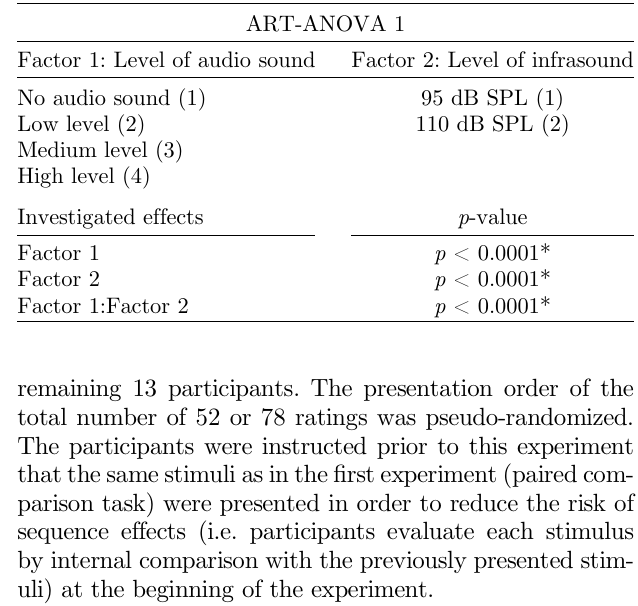
Table 2. The factors values, investigated effects and p -values of ART-ANOVA 1 are listed. Signi fi cant effects and signi fi cant interactions ( p < 0.05) are indicated by an asterisk. The factor value “ low level (2) ” of the factor ‘ level of audio sound ’ includes the unpleasantness ratings averaged over the ratings for the sinusoid at 1000 Hz at 20 dB SPL and for the broadband at 21 dB SPL. In addition, the factor value “ medium level (3) ” includes the unpleasantness ratings averaged over the ratings for the sinusoid at 1000 Hz at 50 dB SPL and for the broadband at 36 dB SPL, and the factor value “ high level (4) ” includes the averaged ratings for the sinusoid at 1000 Hz at 70 dB SPL and for the broadband at 53 dB SPL,